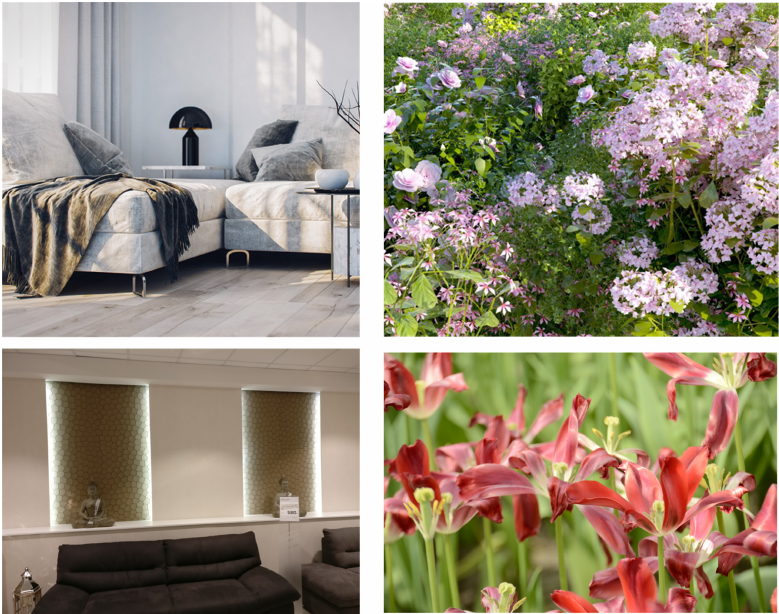
Figure 1. Examples of CG images and NIs. The two CG images on the top row were generated respectively by the VRay [9,10] and Corona [11] rendering engines, and the two NIs on the bottom row are, respectively, from the VISION [12] and RAISE [13] datasets. From top left to bottom right, reproduced with permissions respectively from Qusay Abobaker, 2022; from P&M Studio, 2022; from authors of [12], 2017; and from authors of [13],